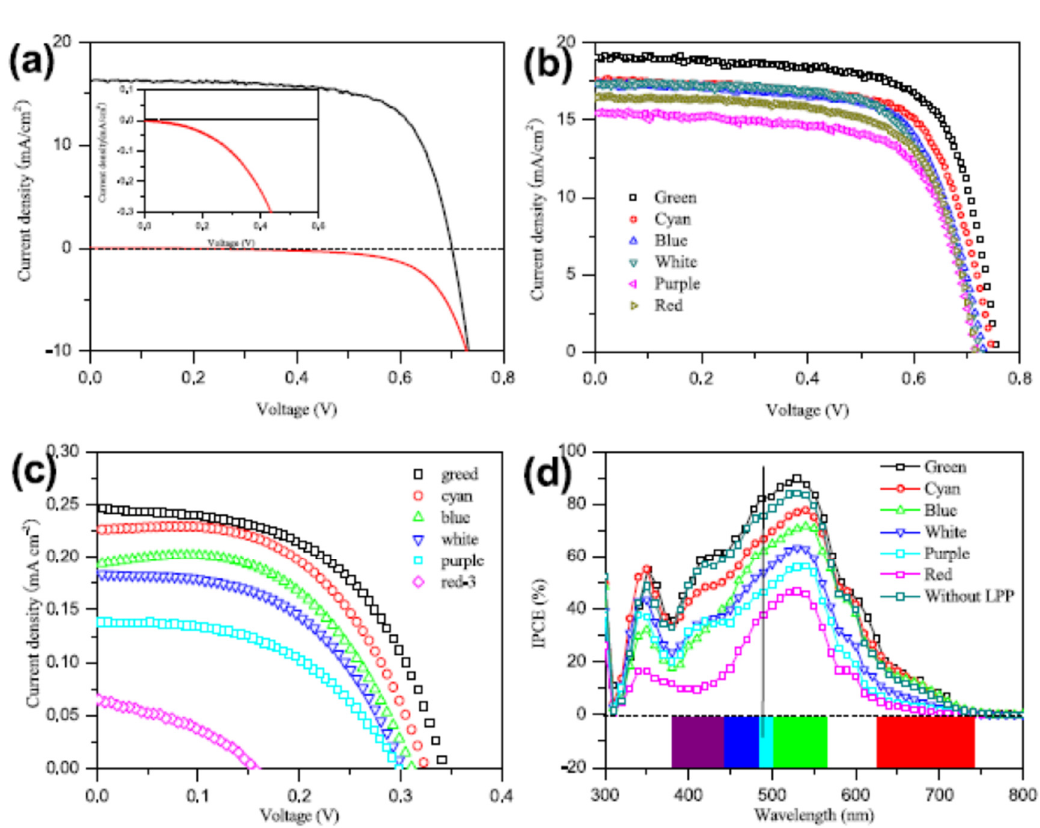
Figure 12. ( a ) Representative photo and dark J–V characteristics of the DSSC including a dye-sensitized TiO 2 anode, a I − /I 3 − redox electrolyte, and a Pt CE. The inset means the magnified dark J–V curve. ( b ) Characteristic photo J–V curves for all-weather DSSCs. An all-weather DSSC device comprises a dye sensitized TiO 2 /LPP photoanode, a I − /I 3 − redox electrolyte, and a Pt CE. ( c ) The J–V curves for all-weather DSSCs recorded under completely dark conditions. ( d ) IPCE plots of the DSSCs with and without LPP phosphors. All photo J–V curves are measured under simulated sunlight (AM1.5, 100 mW cm − 2 ). The dark J–V curves are recorded in atmosphere with light intensity of 0 mW cm − 2 . Reproduced with permission from [10] © 2021 Elsevier B.V. Table 5. The photo (first part) and dark (second part) photovoltaic parameters for corresponding solar cells. η : power conversion efficiency; V oc : open-circuit voltage; J sc : short-circuit current density; FF: fill factor. Reproduced with permission from [10] © 2021 Elsevier B.V.